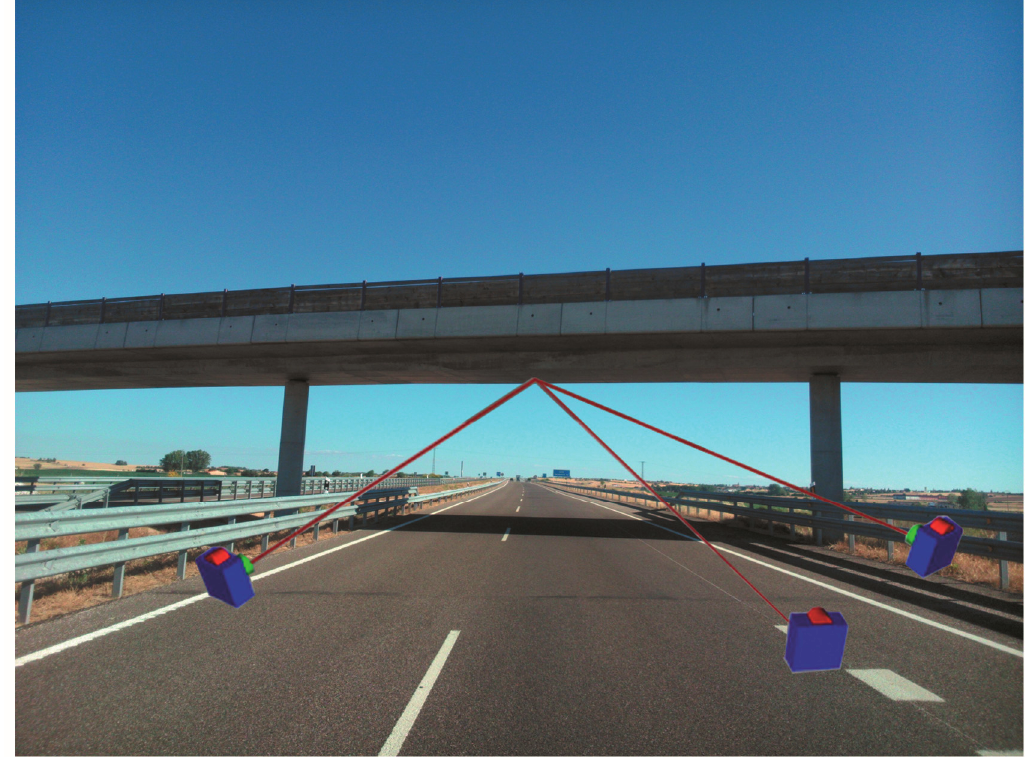
Figure 3. Optimum configuration of the cameras of a convergent multi-station network for data acquisition during the inspection of clearance heights below overhead roads. This camera configuration is optimal, since it provides good intersection angles, as well as a validation based on the third right